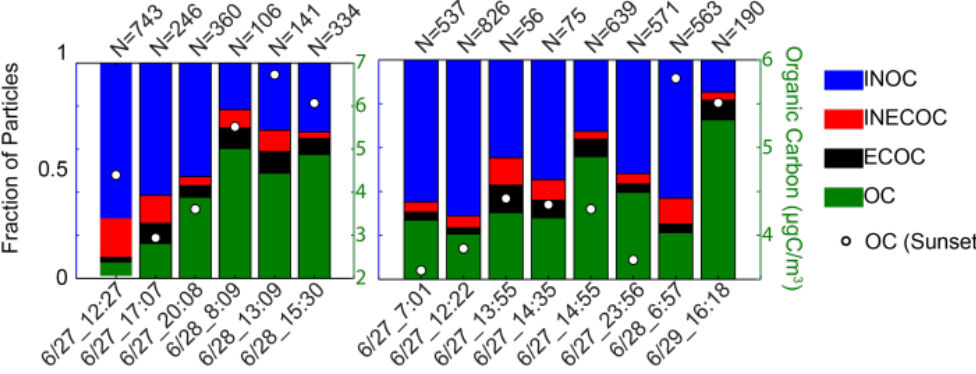
Figure 7. Fractions of STXM-derived particle types for different sites (T0 and T1), dates, and times. White dots show organic carbon mass concentration determined by the Sunset OCEC analyzer.